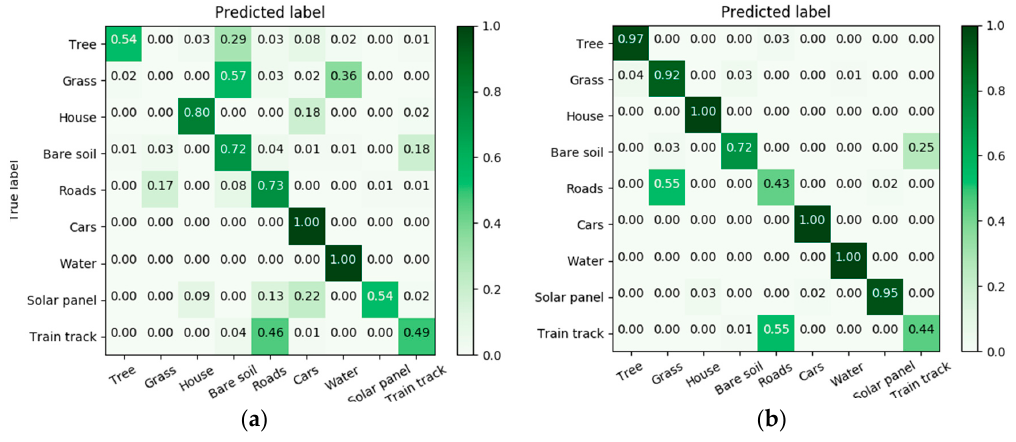
Figure 11. Confusion matrices for Toronto → Vaihingen: ( a ) NN; ( b ) Siamese-GANs.